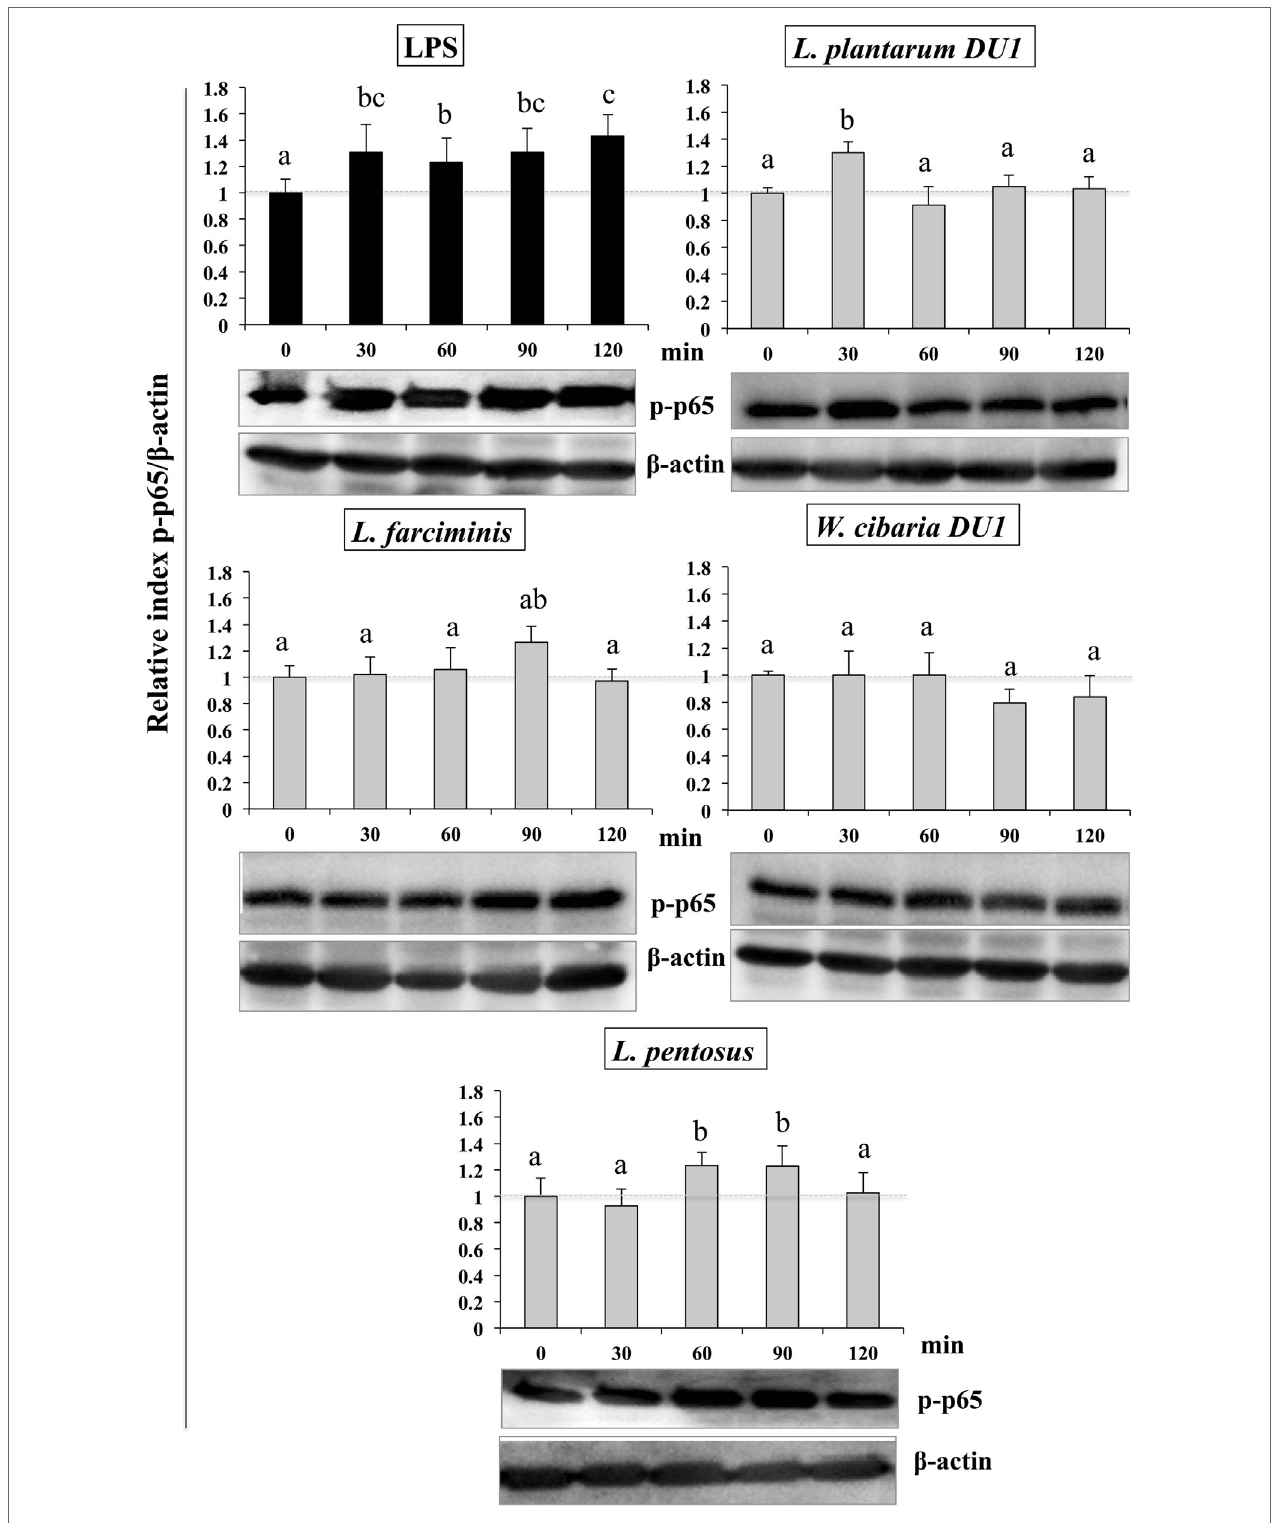
FigUre 9 | Total cellular fluid (TCF) of lactic acid bacteria (LABs) upregulated expression of p65 NF- κ B in hepatoma HepG2 cells. Confluence HepG2 cells were pre-stimulated with LABs total cellular fluid (TCF) (50 µl/ml) for 48 h, then stimulated with LPS for different time intervals (0, 30, 60, 90, and 120 min). Western blot was performed to determine the degradation of p65 NF- κ B at the indicated time points. The bar graphs represent the results of three independent experiments. The image J software was used to determine the intensities of protein bands. Different superscript letters indicate significant differences at the 0.05